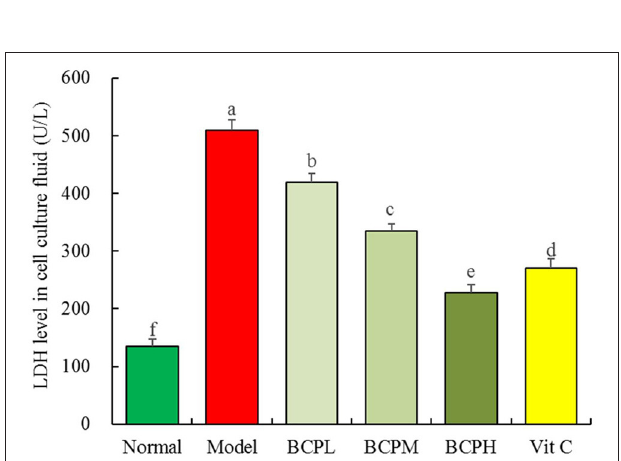
FIGURE 6 | Effect of BCP on LDH level of H9c2 cells with OS injury. a − f Mean values with different letters over the bar are significantly different ( P < 0.05) according to Tukey’s honestly significant difference.